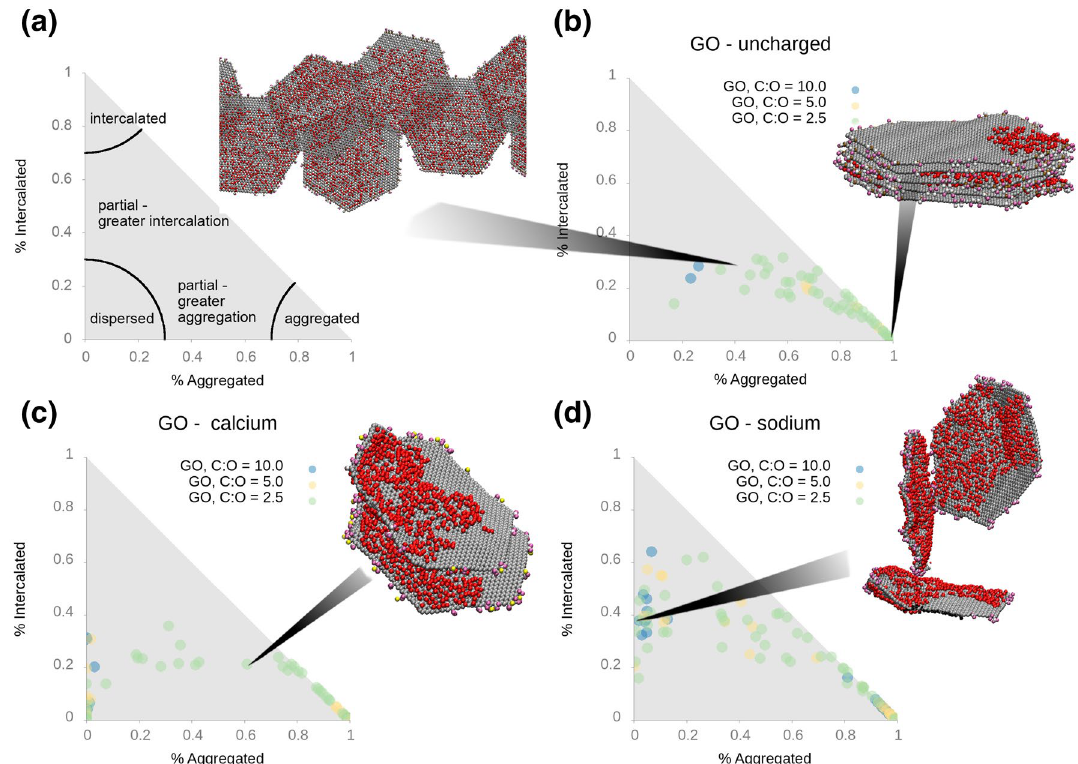
Figure 2. The final morphologies of graphene oxide flakes simulated in aqueous solution. Panel ( a ) illustrates our morphology classification as a function of % of atoms in aggregated and dispersed environments. ( b ) corresponds to protonated carboxylic acid groups on the edge of the graphene flakes, i.e. low pH; ( c ) corresponds to unprotonated (charged) carboxylic acid groups with Ca 2 + counterions; ( d ) corresponds to unprotonated (charged) carboxylic acid groups with Na + counterions. Each point represents a flake: on each graph there are 3 different oxidation states, each with 9 replica simulations comprising 5 flakes, resulting in a total of 135 points. The average values for each system are listed in Supporting Information Table